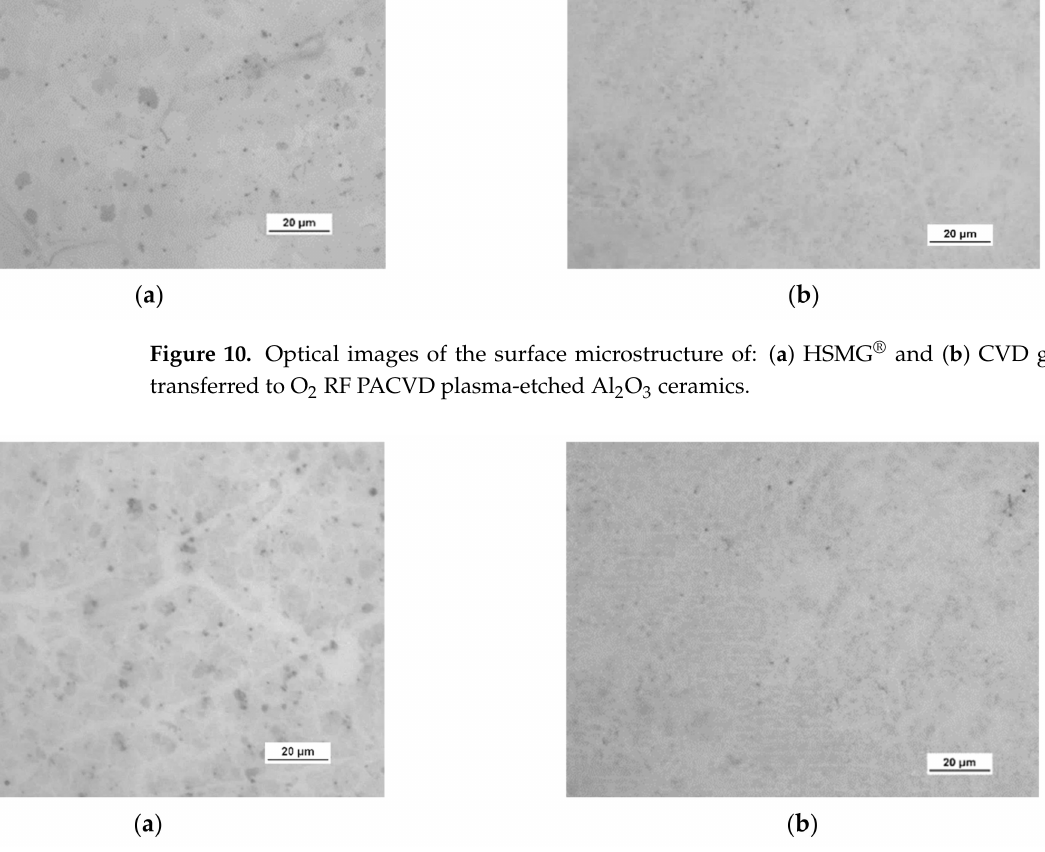
Figure 11. Optical images of the surface microstructure of ( a ) HSMG ® and ( b ) CVD graphene transferred to barrier discharge plasma (DBD)-etched Al 2 O 3